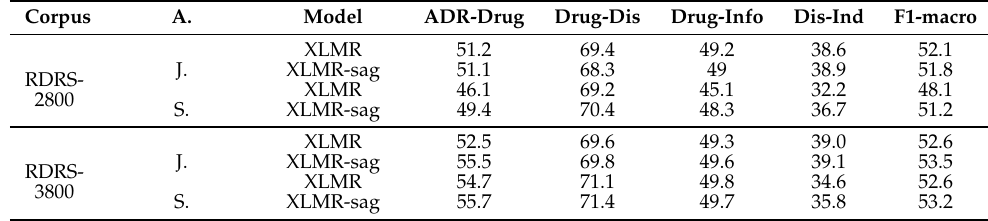
Table 8. Accuracy on the extended version of the RDRS dataset using joint (J.) and sequential (S.)